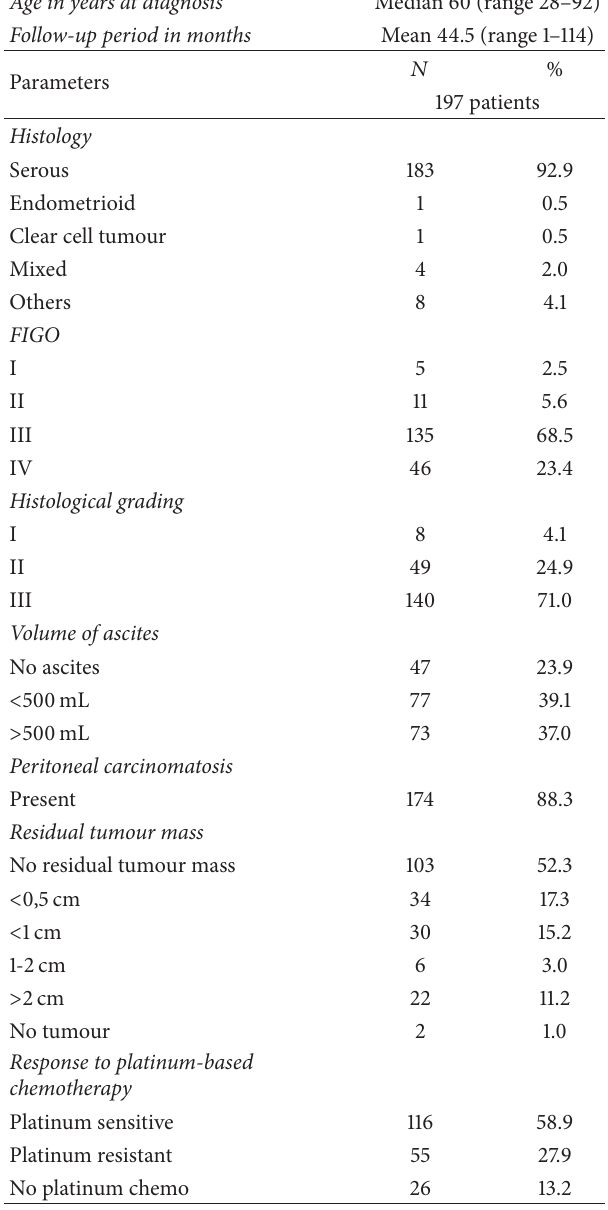
Table 1: Patient’s clinical and pathologic characteristics.